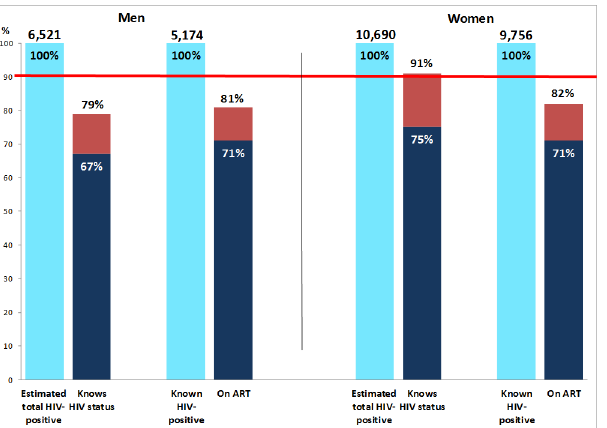
Fig 4. 90–90 estimates for the total population, at the start and end of Round 2. Dark blue bars show the estimated percentage of HIV+ individuals who knew their HIV+ status (first 90 target) and the estimated percentage who were on ART among those who knew their HIV+ status (second 90 target), immediately prior to the Round 2 annual visit. Red bars show the same estimated percentages, by the end of Round 2. ART, antiretroviral therapy.